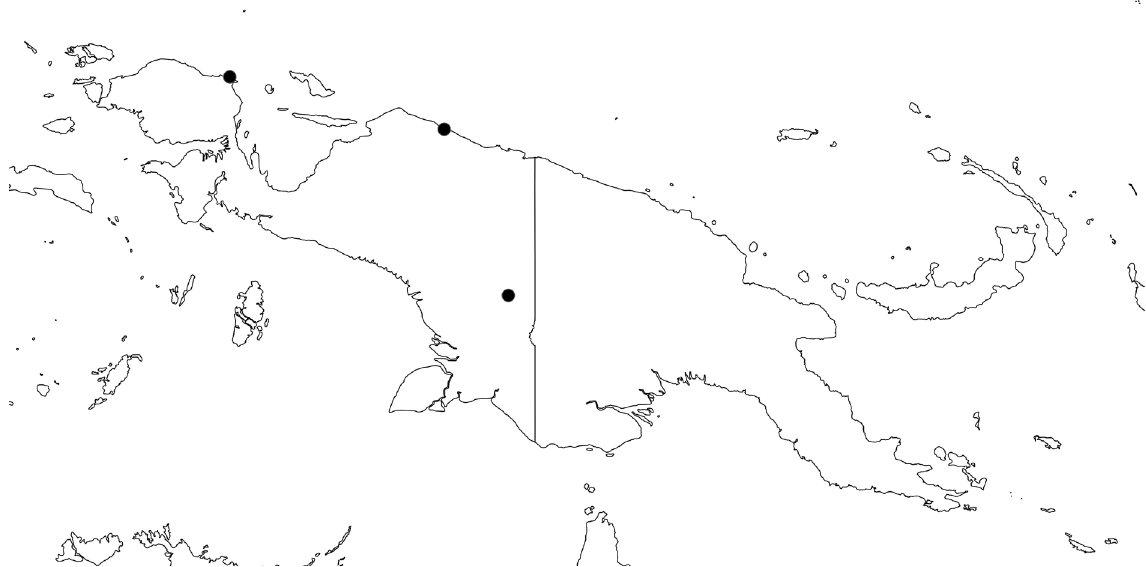
Fig. 2. Map of New Guinea showing the collecting localities of Monoon pachypetalum I.M.Turner & Utteridge sp.